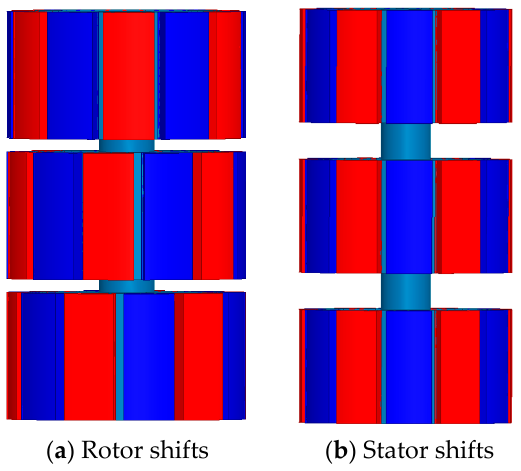
Figure 14. Three-phase topology of CPM, ( a ) Rotor shifts, and ( b ) Stator shifts.